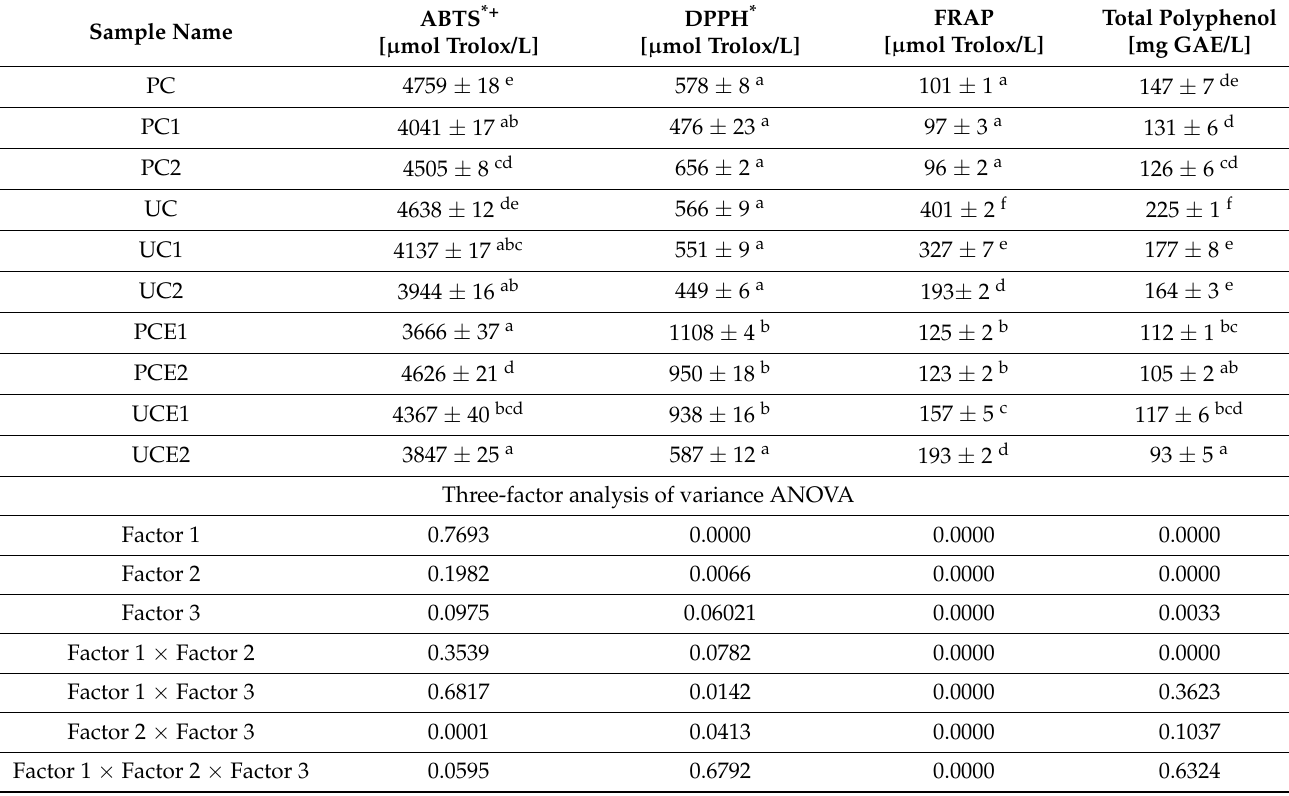
Table 2. Effect of pectinase on celeriac pulp on antioxidant properties and total polyphenol